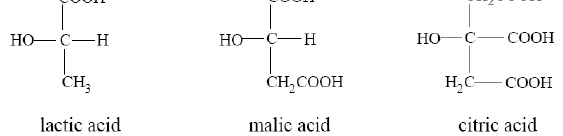
Figure 5. Structures of lactic, malic, and citric acids.